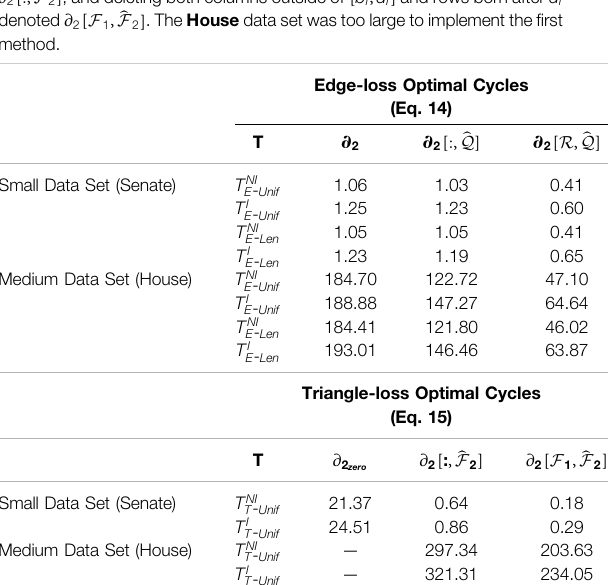
TABLE 3 | Computation time of three differently sized input boundary matrices to edge-loss and triangle-loss methods. The superscripts denote whether the